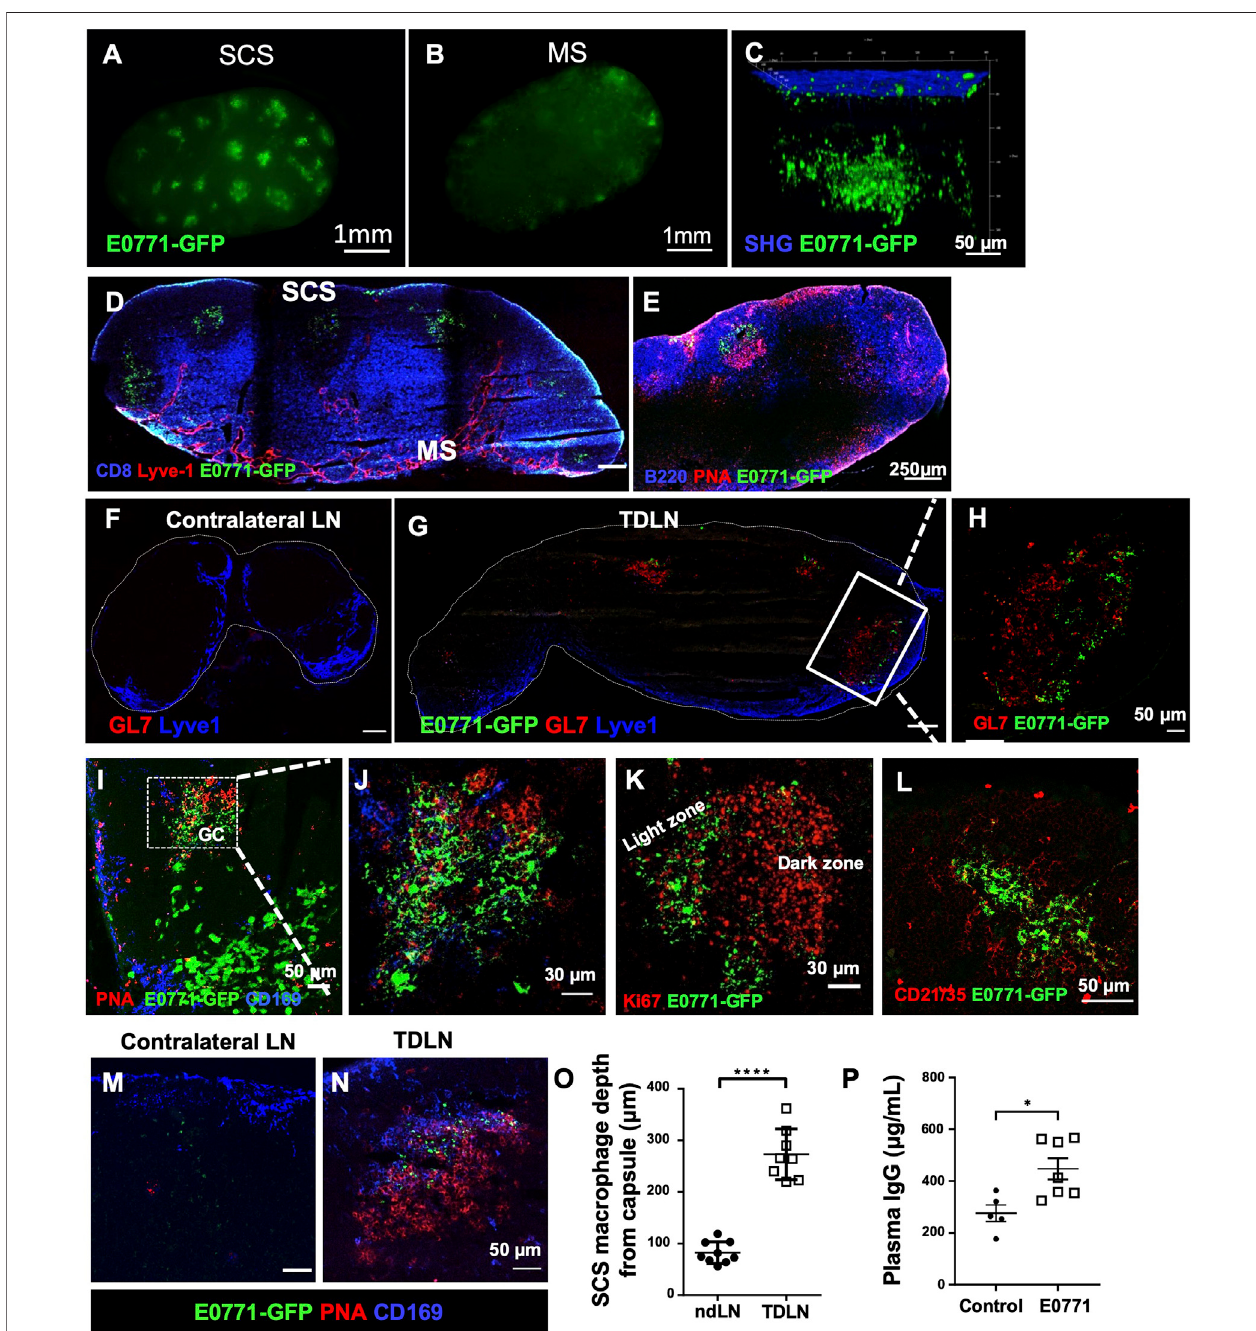
FIGURE1| Tumor-associatedantigensaccumulate at thegerminal centers (GCs). (A,B) Whole-mountimages byastereotype microscopeshow thesubcapsular sinus(SCS)side (A) andthemedullarysinus(MS)side (B) ofday21E0771-GFPTDLN. n =5. (C) MultiphotonmicroscopicimageshowsGFP + tumor-associatedantigen underlying the LN capsule, visualized by second-harmonic generation (SHG). n = 5. (D – J) . GFP accumulates in the B cell zone of TDLN, but not in the ndLN. GCs were highlightedbyPNAandGL7. (K) GFPlocalizedinthelightzoneoftheGCasthedarkzonewasindicatedbyKi67staining. (L) GFPwasdepositedintheCD21/35 + follicular dendritic cells (FDCs) of the TDLNs. n = 5. (M – O) CD169 staining show the location of SCS macrophages in the TDLN. Image quanti fi cation of CD169 + macrophagesstainingshowedthemsigni fi cantlydeeperintheLNcortex.Dataismean±SEM.**** p < 0.0001.Mann-WhitneyUtest.Imagesarerepresentativeof n =8- 9 per group, repeated three times. (P) E0771 mice show signi fi cantly higher plasma IgG compared to control wild-type mice. Data is mean ± SEM. * p < 0.05. Mann- Whitney U test ( n = 5 – 7 per group, in two separated studies).